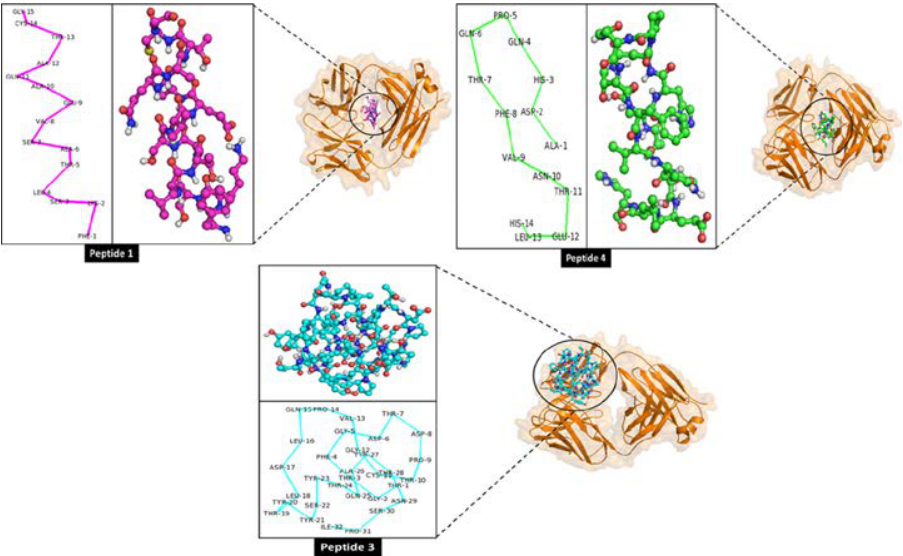
Fig. 4. Structure visualization of sticks, spheres, and transparent surfaces of molecular complexes consisting of peptide-based vaccine candidate with BCR/Fab (orange).